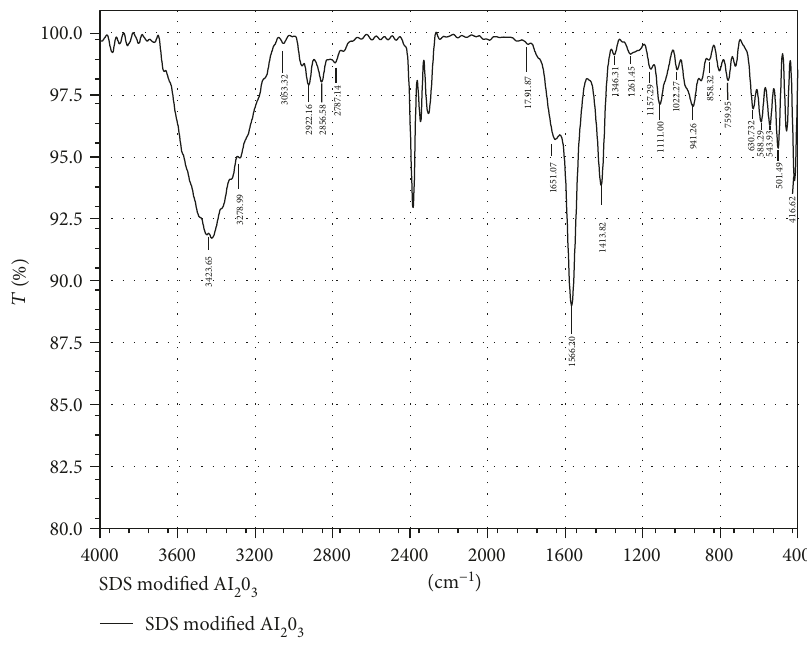
Figure 9: FTIR spectrum of γ -Al